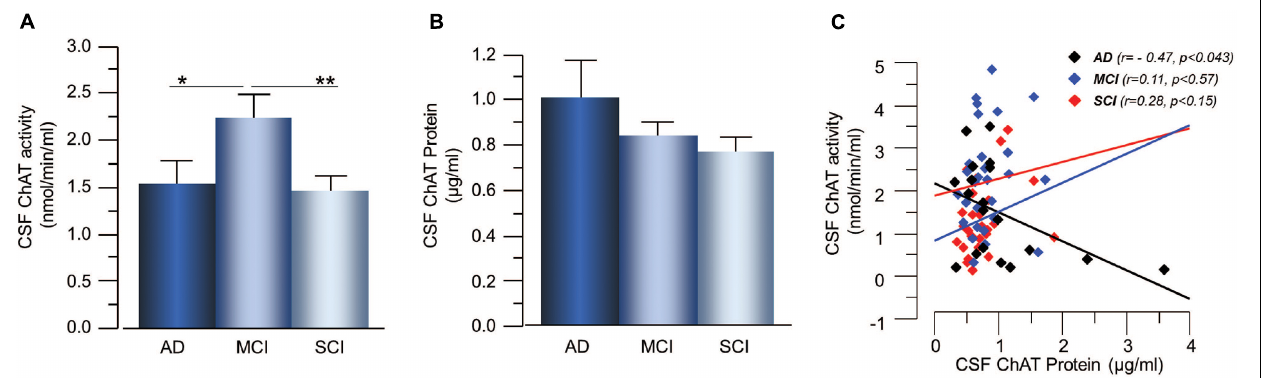
FIGURE 1 | Changes in ChAT levels in CSF of patients in different stages of dementia. (A) CSF ChAT activity was higher in patients with the clinical diagnosis of MCI than in AD or SCI. (B) The corresponding ChAT protein concentrations in CSF did not show any significant differences. (C) The activity and protein concentration of ChAT in CSF exhibited negative correlation mainly in the AD group. AChE = acetylcholinesterase; AD = Alzheimer’s disease; ChAT = choline acetyltransferase; CSF = cerebrospinal fluid; MCI = mild cognitive impairment; SCI = subjective cognitive impairment. * p < 0.05, ** p <